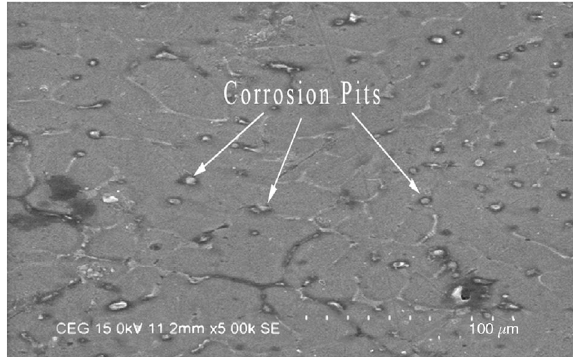
Figure 11: Corrosion pits of the Al/GO composite.